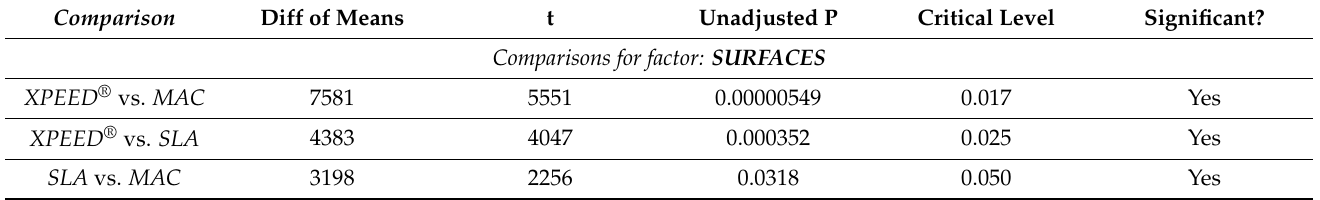
Table 4. Summary of all Pairwise Multiple Comparison Procedures (Holm–Sidak method): Overall significance level =